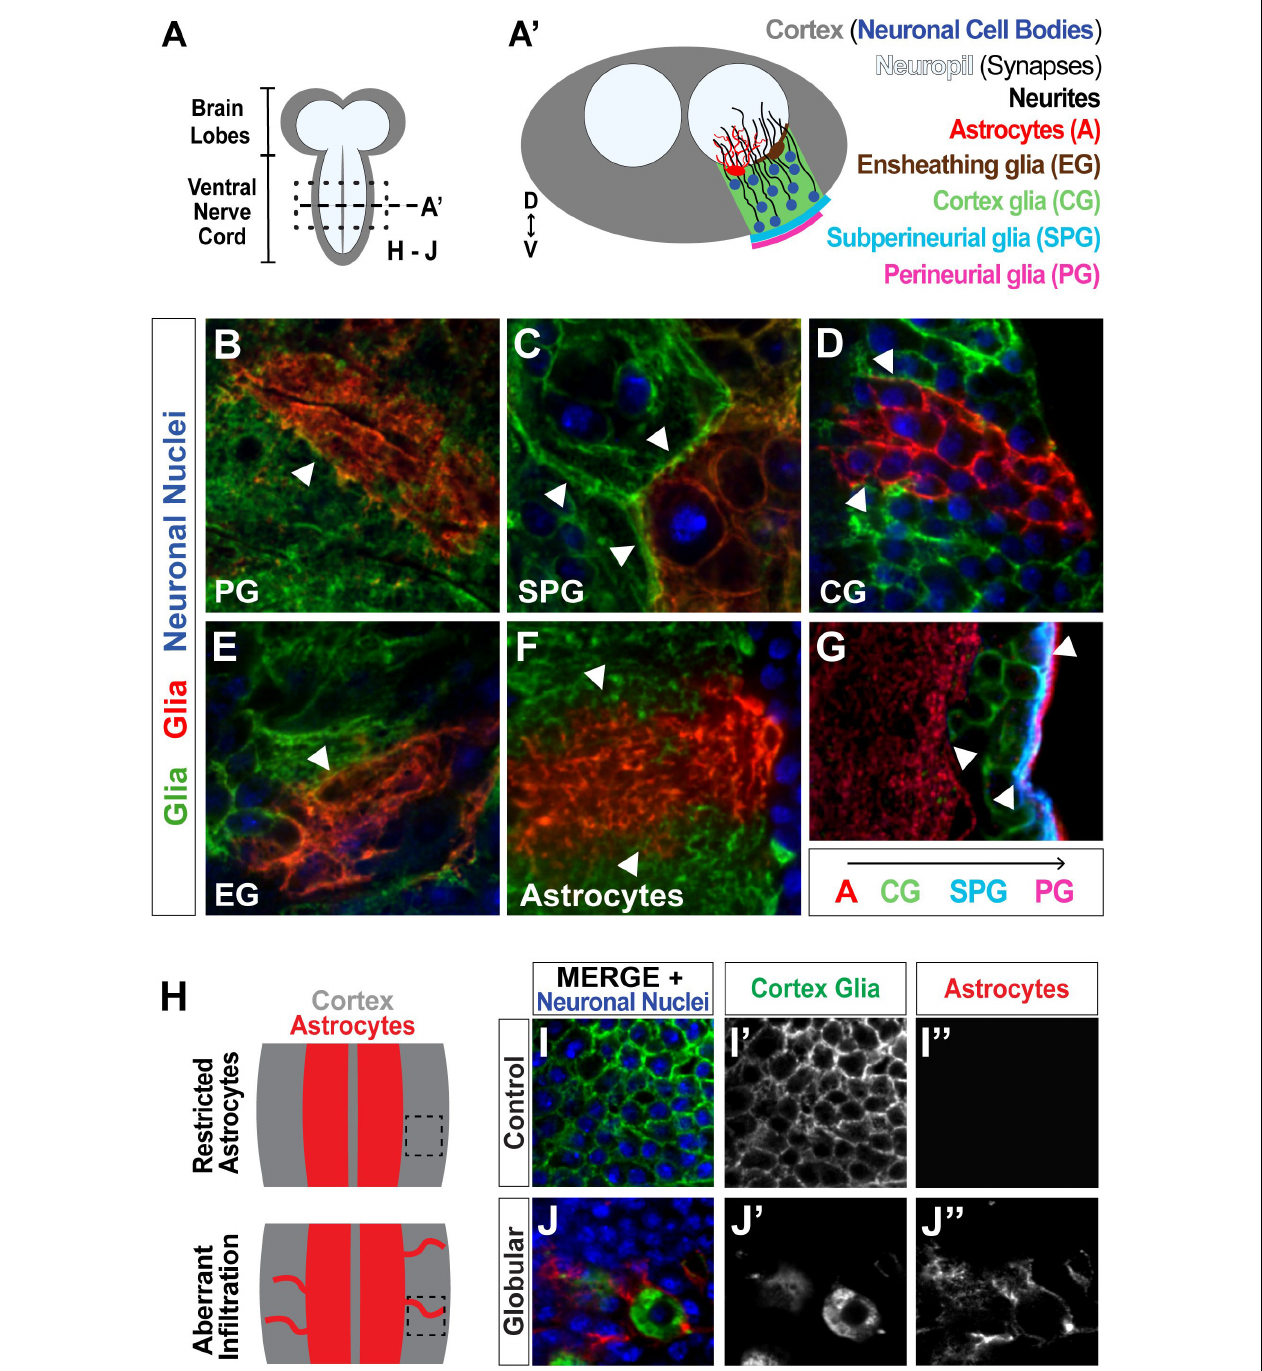
FIGURE 1 | Drosophila serves as a strong model for investigating glial tiling. (A) Schematic of the Drosophila melanogaster larval central nervous system (CNS), subdivided into the cortex (gray, containing the cell bodies) and the synaptic neuropil (white). (A’) Cross-section of the ventral nerve cord (VNC) depicting neuronal nuclei (blue) and single cell examples of different glial subtypes to show their distinct spatial segregation: Perineurial glia (PG, magenta) and subperineurial glia (SPG, cyan) form a barrier around the CNS, cortex glia (CG, green) wrap neuronal cell bodies, and ensheathing glia (EG, brown) and astrocytes (red) are associated with the neuropil. (B–F) Tiling between cells of the same glial subtype shown in green and red with neuronal nuclei shown in blue: PG ( B , surface view), SPG ( C , surface view), CG (D) , EG ( E , surface view), astrocytes (F) . (G) Tiling between different glial subtypes: PG (magenta), SPG (blue), CG (green), astrocytes (red). Examples of tiling boundaries depicted with white arrowheads. (H) Schematic illustrating astrocyte aberrant infiltration (red) into the cortex (gray) upon disruption of CG morphology. (I,J) Images corresponding to black inset in (H) , showing control (I) and globular (J) cortex glial conditions, where astrocytes can be seen infiltrating the cortex in (J”) . Cortex glia in green (I’,J’) , astrocytes in red (I”,J”) , neuronal nuclei in blue.